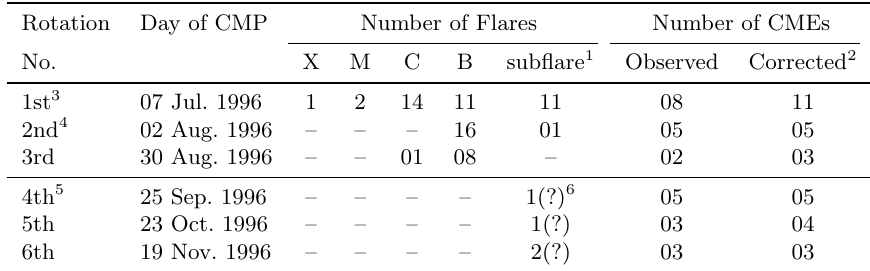
Table 6: Evolution of flare and coronal mass ejection (CME) activity during the lifetime of an isolated active region NOAA 7978 (July – November 1996; based on D´emoulin et al. (2002b). Rotation Day of CMP Number of Flares Number of